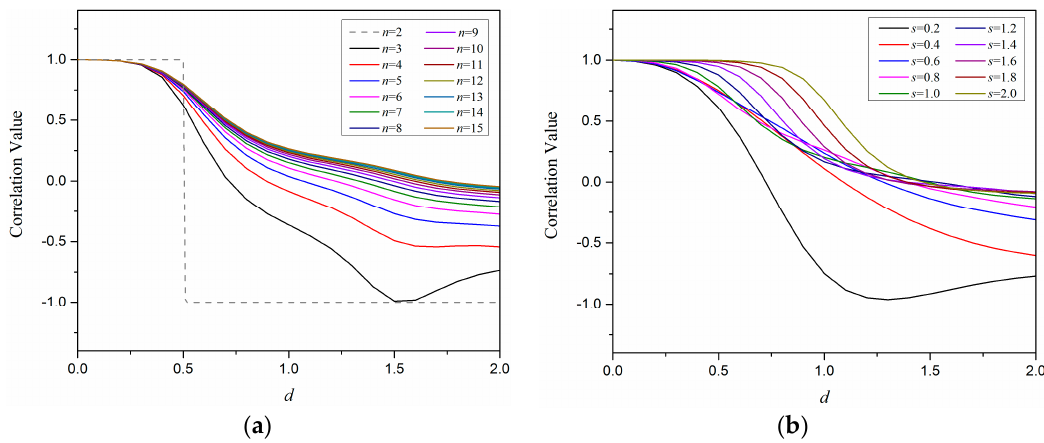
Figure 4. The relationships between correlation values and relative distances of two force loads with different sensor array distributions in terms of: ( a ) the number of sensor units from 2 to 15; and ( b ) the spacing parameter of sensor units from 0.2 to 2.